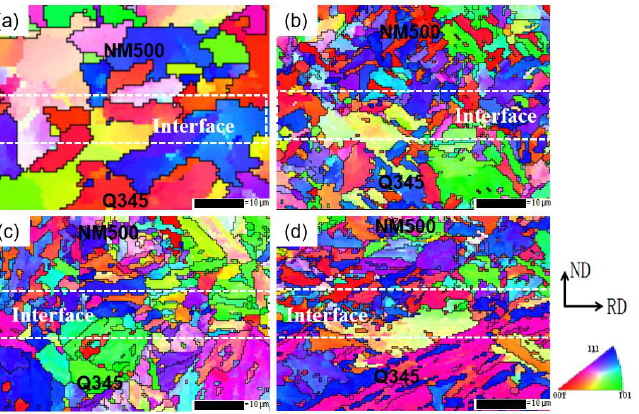
Figure 3. Microstructure IPF of NM500/Q345 composite board in different states: ( a ) original; ( b ) 860 ◦ C + 200 ◦ C; ( c ) 900 ◦ C + 200 ◦ C; ( d ) 940 ◦ C + 200 ◦